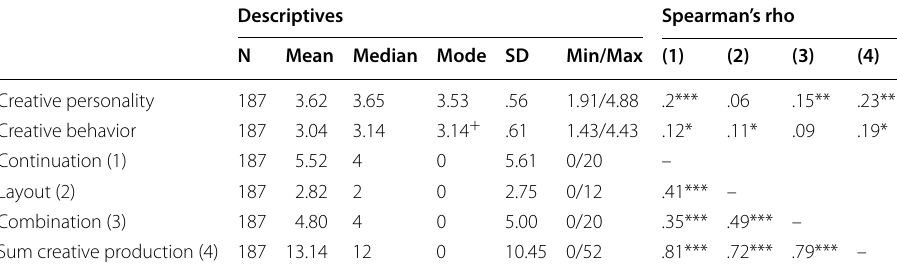
Table 2 Descriptives for creativity variables and bivariate correlation coefficients